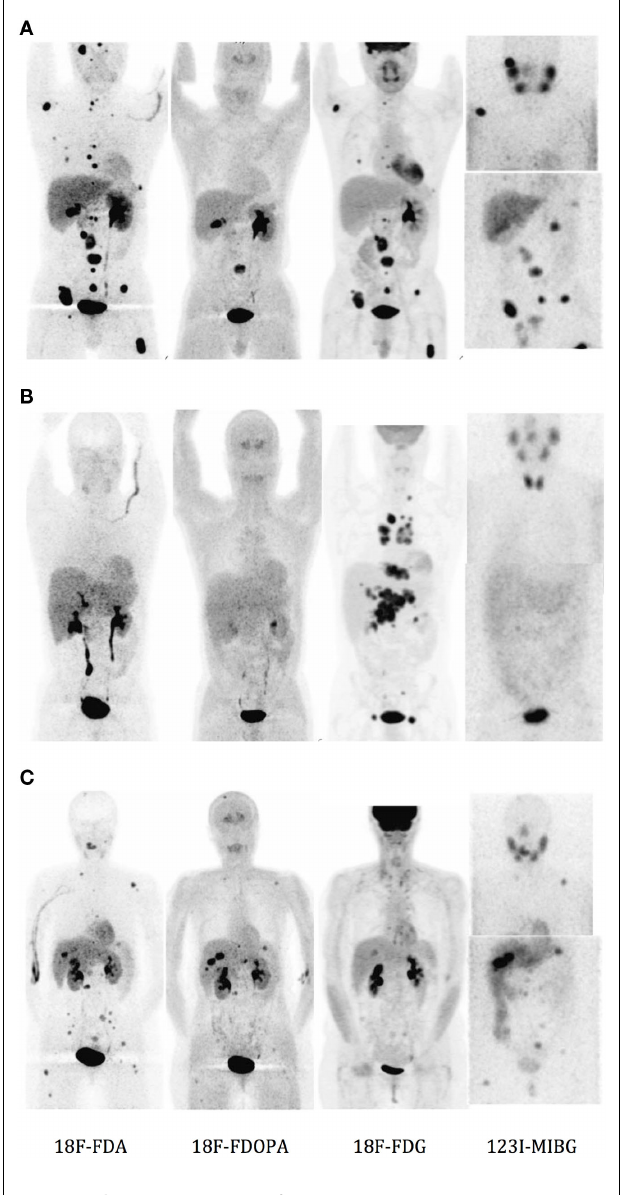
FIGURE 2 | Functional imaging (from left to right, with 18F-FDA, 18F-DOPA, 18F-FDG, and 123I-MIBG) in patients with (A) and (B) metastatic SDHB-related paraganglioma, and (C) metastatic RET-related paraganglioma. Anteriorly reprojected images. (Taken from Timmers et al.,